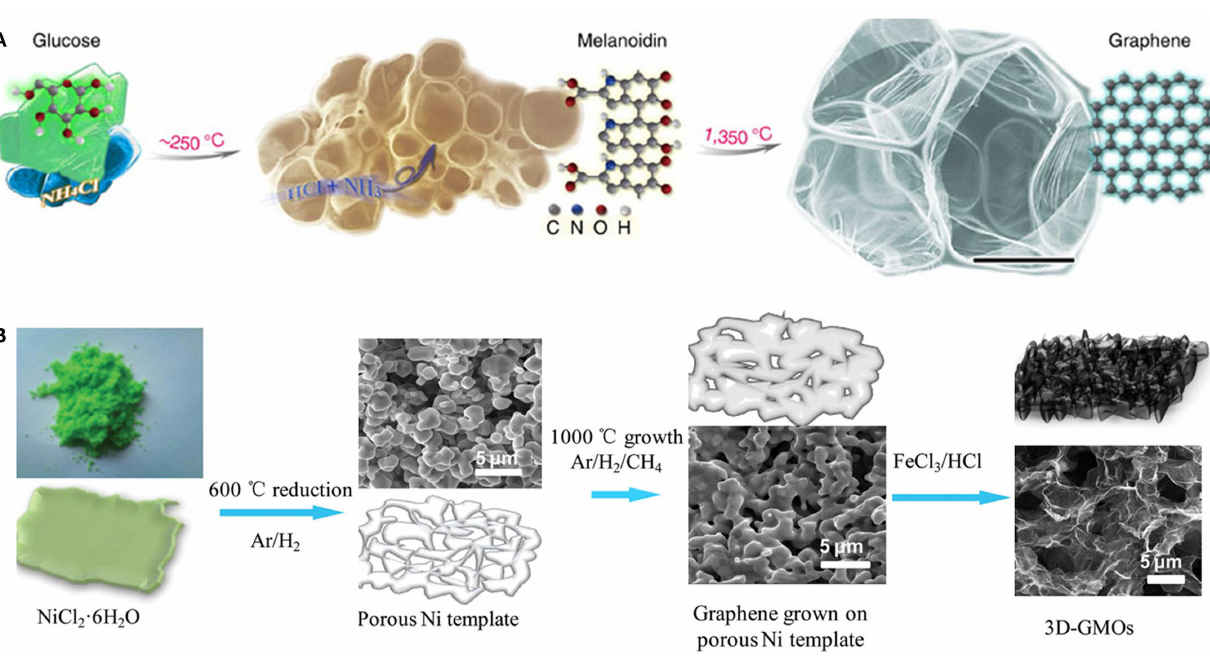
FIGURE 3 | (A) SEM image and schematic growth process of porous graphene structure prepared by sugar-blowing method. Adapted with permission fromWang et al. (2013). Copyright 2013 Nature Publishing Group.